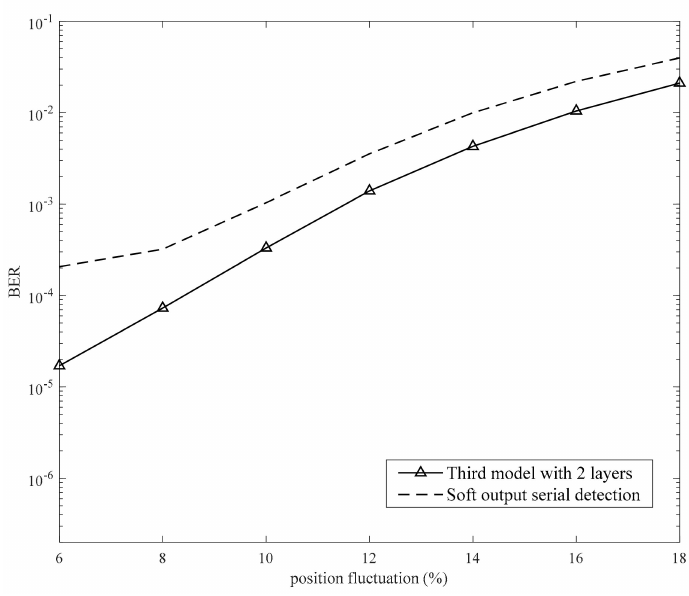
Figure 21. BER vesus fluctuation position from 6% to 18%.